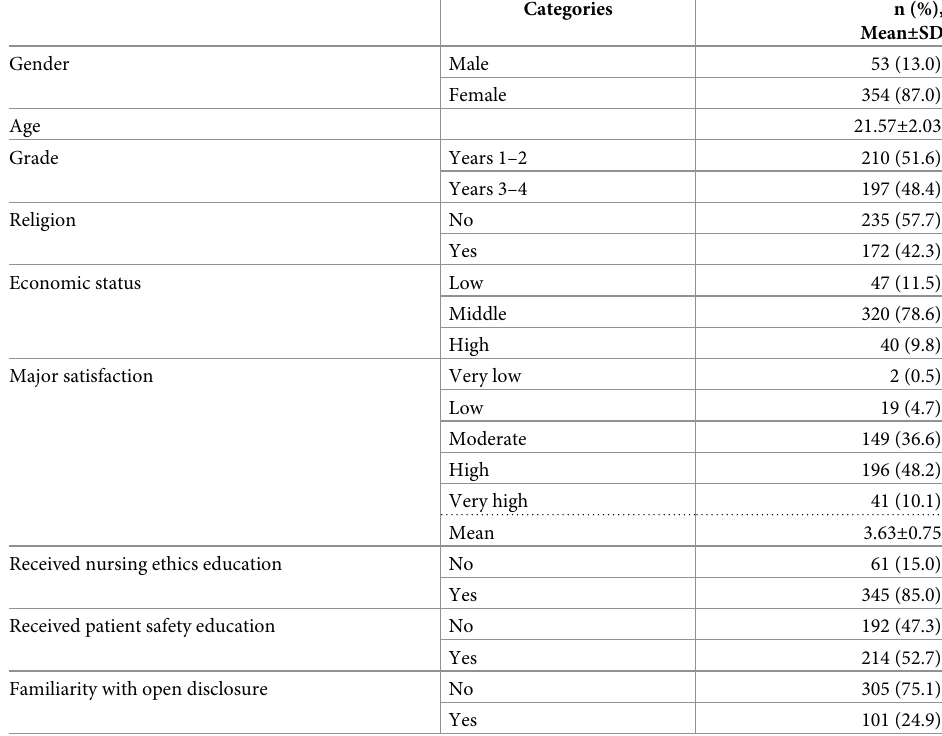
Table 1. General Characteristics of Participants (n =